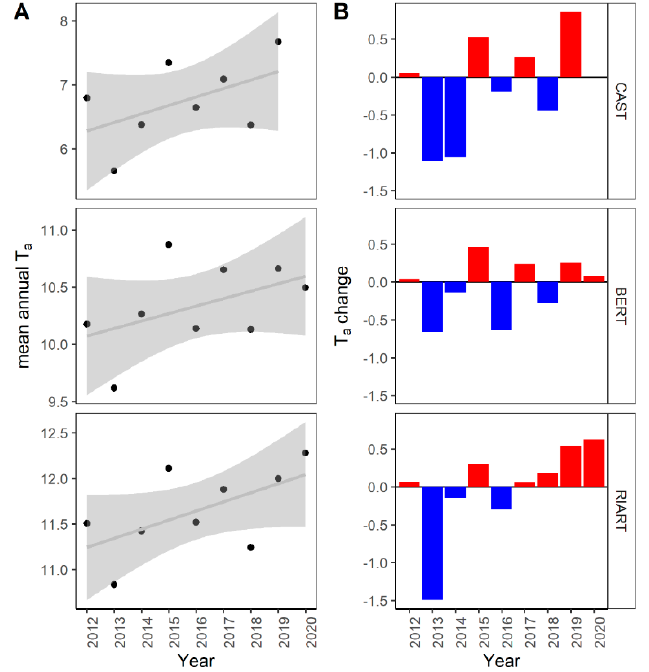
Figure 2. Climogram of the study sites, mean air temperature (T a ), and precipitation. Data sources: T a , eddy covariance flux stations from the period 2012–2020; precipitation from the closest meteor- ological stations of the Servei Meteorologic de Catalunya (see Annex 2).